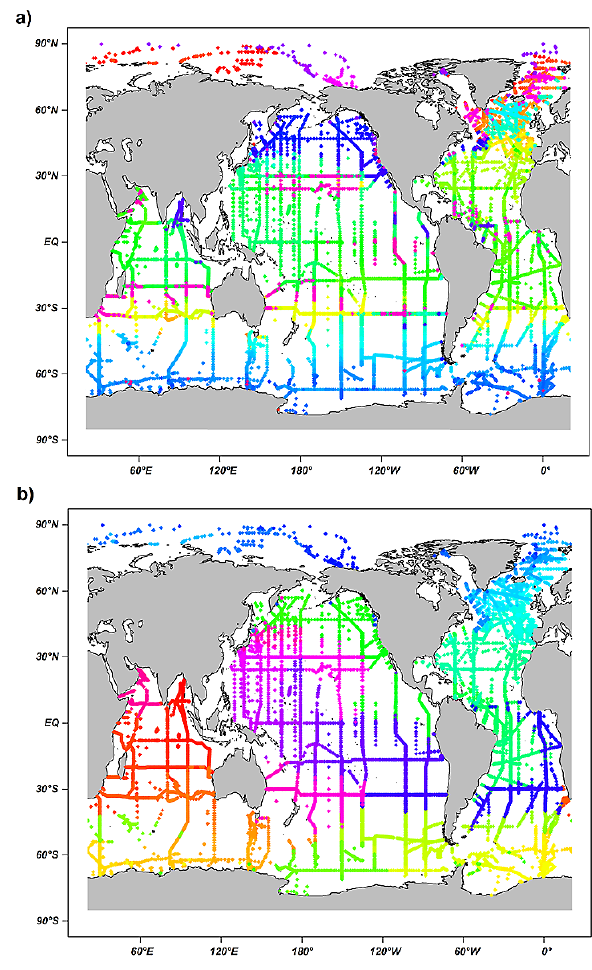
Fig. 9. Distribution of assigned neurons for optimal C T SOM mod- els trained with (a) biogeochemical information only and (b) bio- geochemical and geographical